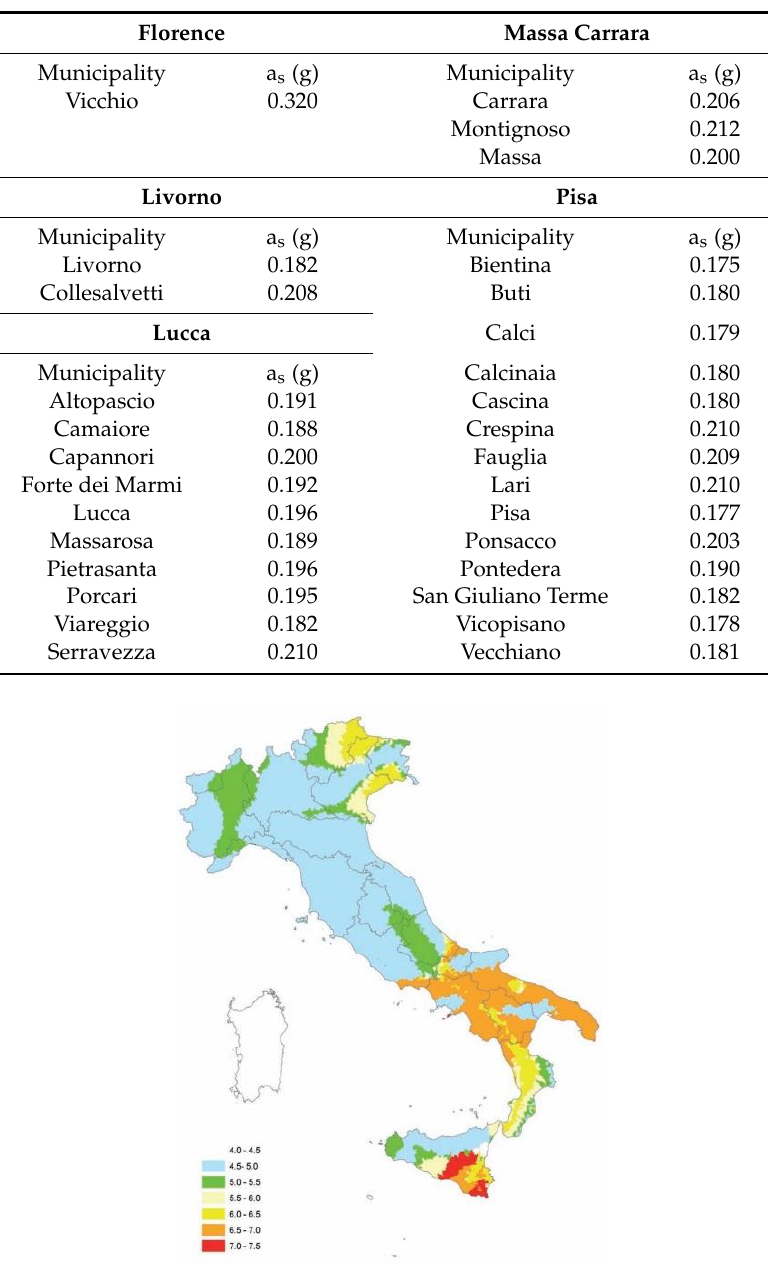
Table 4. Free-field peak ground acceleration (a s ) at each municipality, according to NTC (2018) [46].